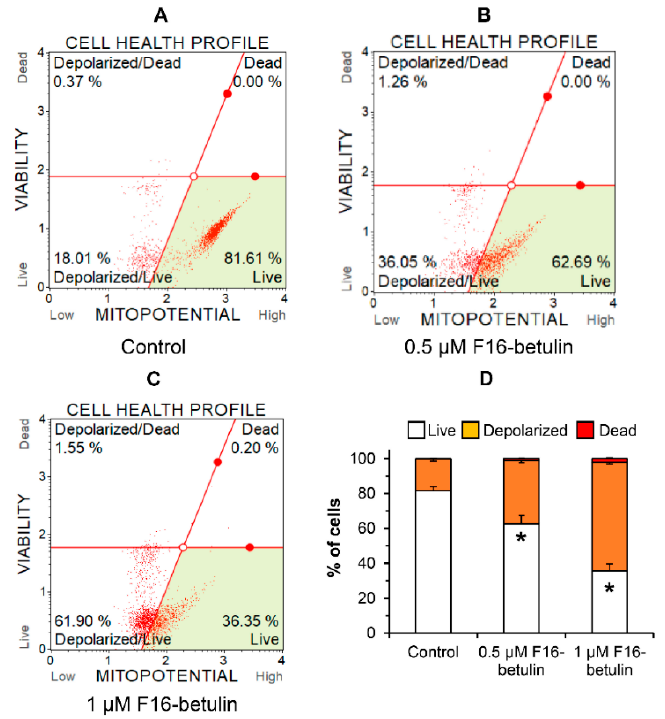
Figure 4. Effect of F16-betulin conjugate on mitochondrial potential of rat thymocytes. The mitochondrial potential of cells was evaluated using the Muse MitoPotential Kit. Typical mitopotential profile plots ( A – C ) are shown. A similar pattern was observed in three independent experiments. Panel ( D ) demonstrates the effect of the conjugate on the distribution of cells losing mitochondrial potential (means ± SEM, n = 3). * p < 0.05 (vs. control).